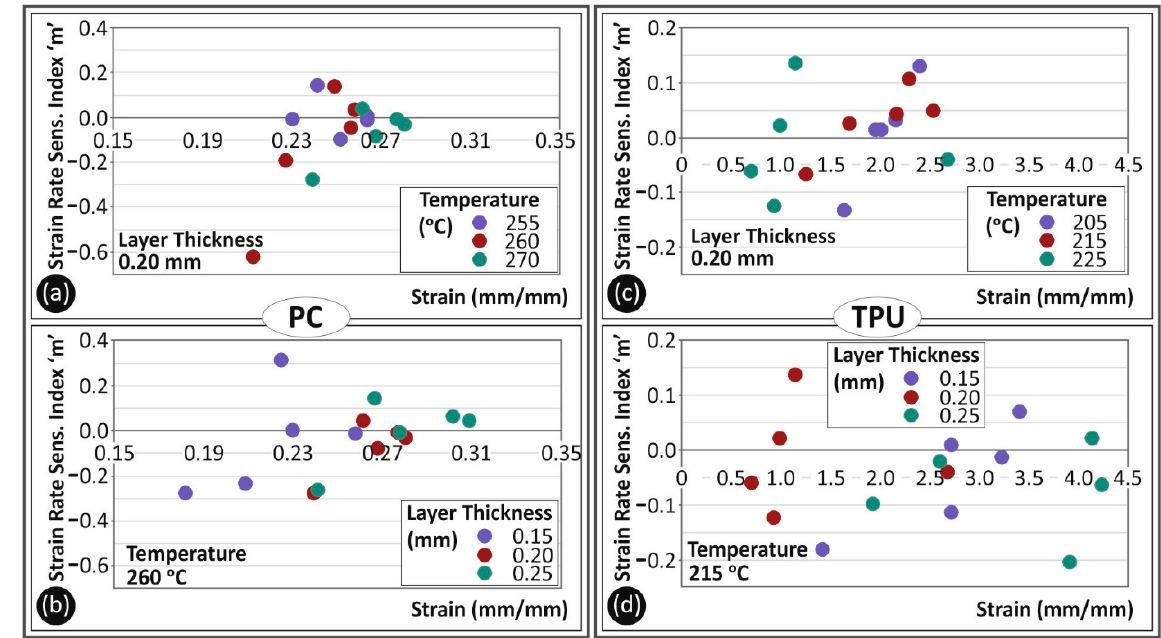
Figure 7. Calculated strain rate sensitivity index ‘m’ to strain at break (mm/mm) for PC ( a , b ) and TPU ( c , d ) materials in comparison with the different temperatures ( a , c ) and layer heights ( b , d ) studied in this work.